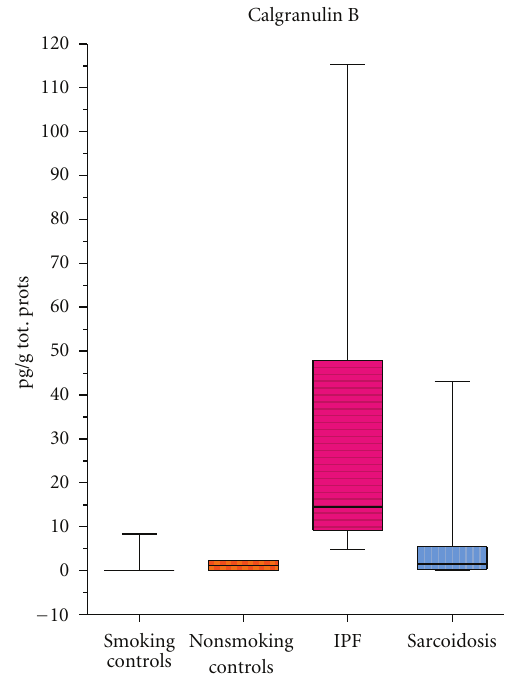
Figure 1: Calgranulin B concentrations in BAL of sarcoidosis, idio- pathic pulmonary fibrosis patients and healthy controls (smokers and nonsmokers). The box extends from the 25th percentile to the 75th percentile, with a line at the median (the 50th percentile). Prism plots the whiskers to extend above and below the box to show the highest and lowest values